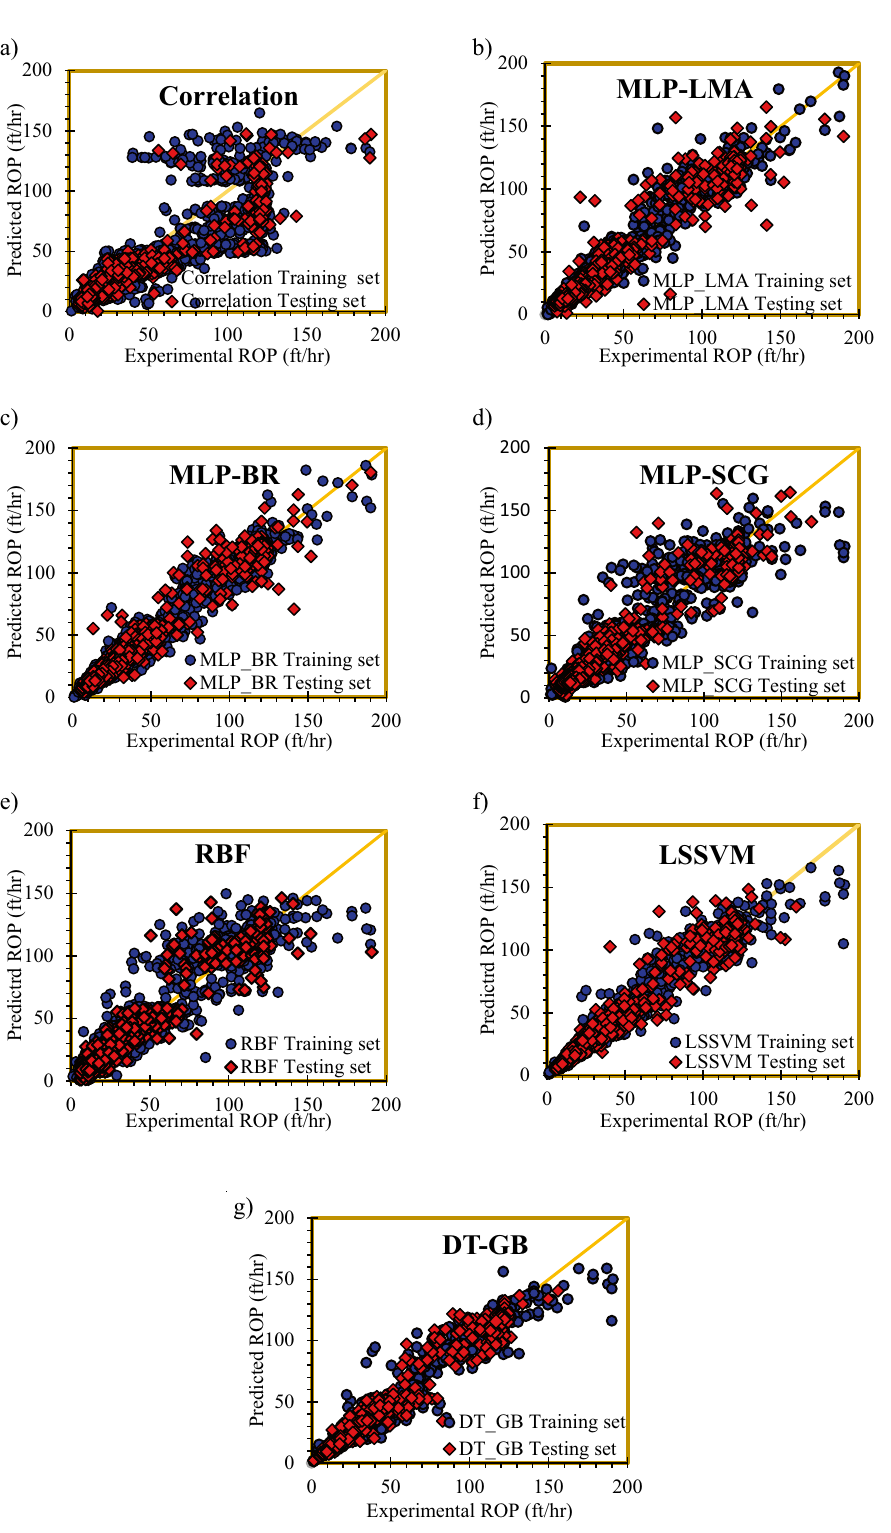
Figure 9. Cross plots of the implemented intelligent